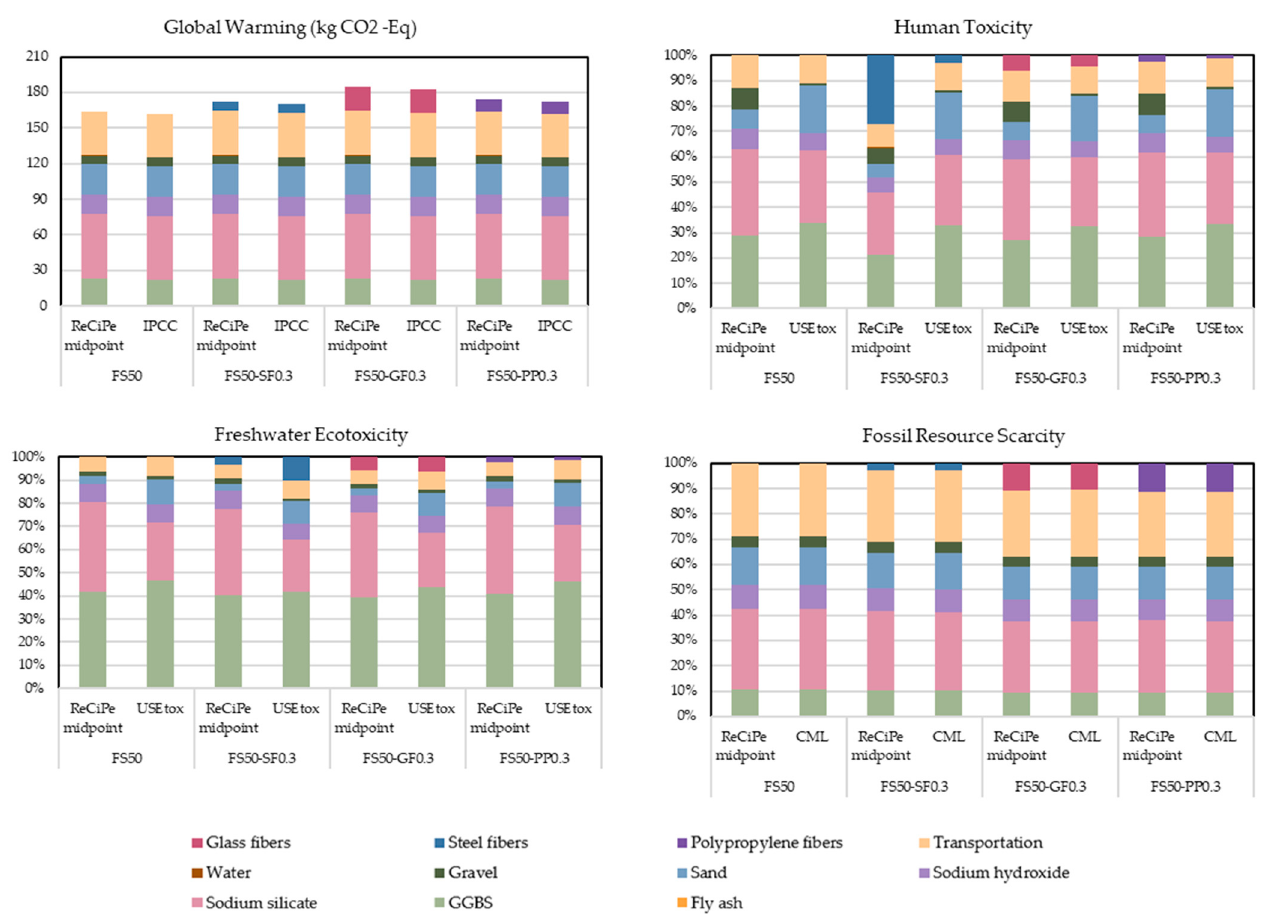
Figure 9. Endpoint impacts of FRAAC.